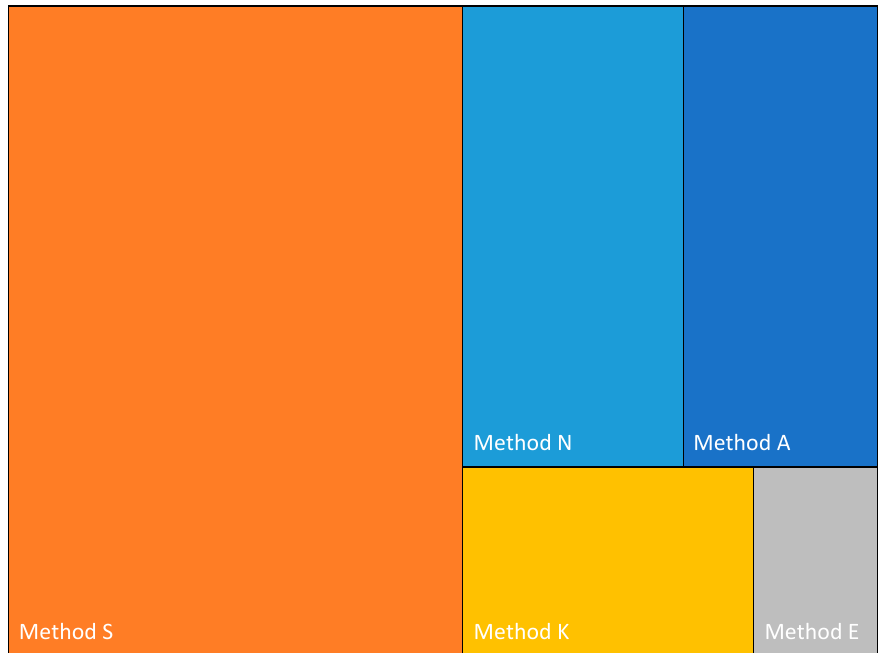
Figure 2. Treemap representation of the time required for the methods evaluated.